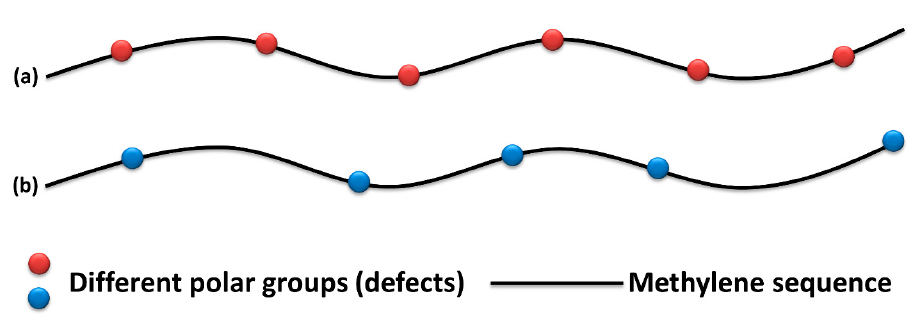
Table 1. List of the polymers under investigation with their chemical structure, short naming, and number average molar mass M n